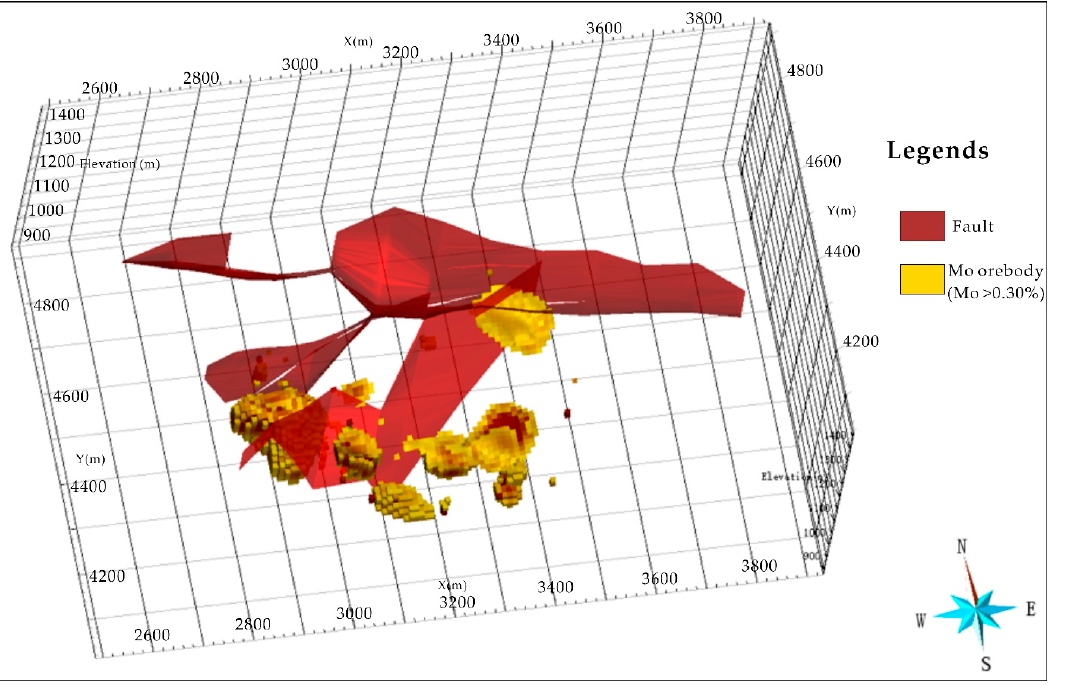
Figure 6. Spatial relationship between rich orebody and main faults (superposition of main faults with ore